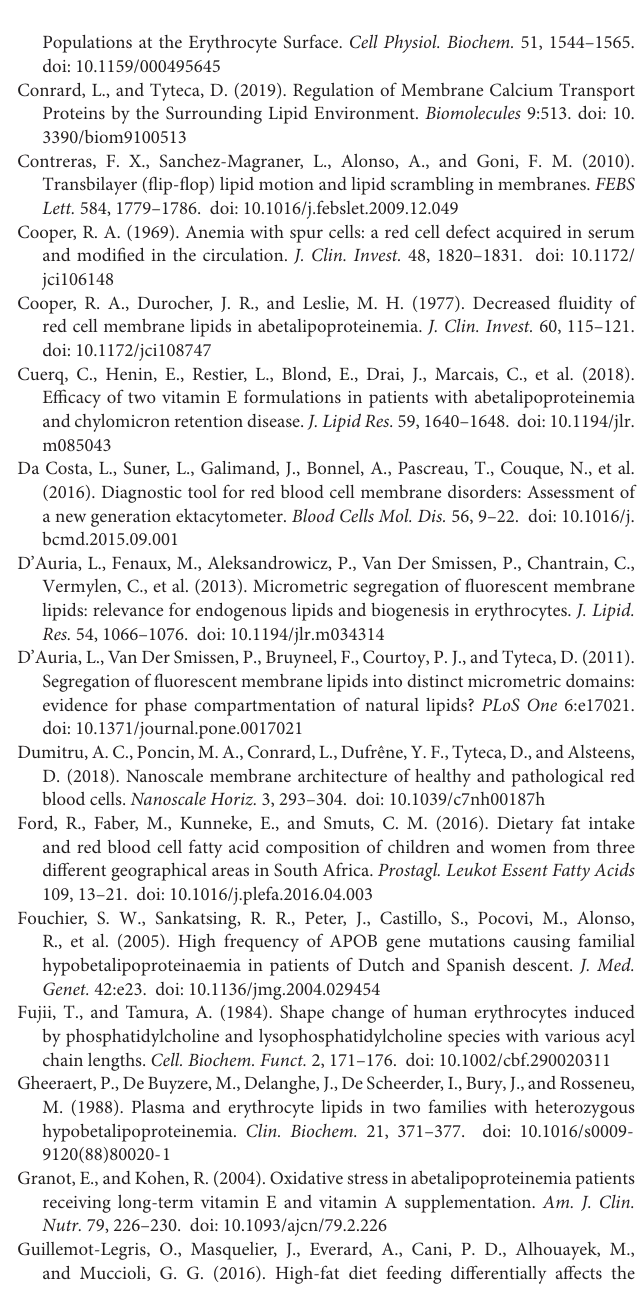
Supplementary Figure 2 | Relation between RBC plasma membrane and cytoskeleton elastic modulus in the fast indentation experiments. RBCs from healthy donors or pHypo β were evaluated for both plasma membrane and cytoskeleton Young’s modulus. Each dot depicts one RBC measured for plasma membrane and cytoskeleton Young’s modulus. Experimental data are from Figure 7B . Supplementary Table 1 | pHypo β clinical data. Clinical parameters were assessed for pHypo β after blood collection. MCV, mean corpuscular volume; MCH, mean corpuscular hemoglobin; Gamma-GT, Gamma-glutamyltransferase; ASAT, aspartate transaminase; ALAT, alanine transaminase; LD, lactate dehydrogenase. Values upon or under the reference values are indicated in red or blue,